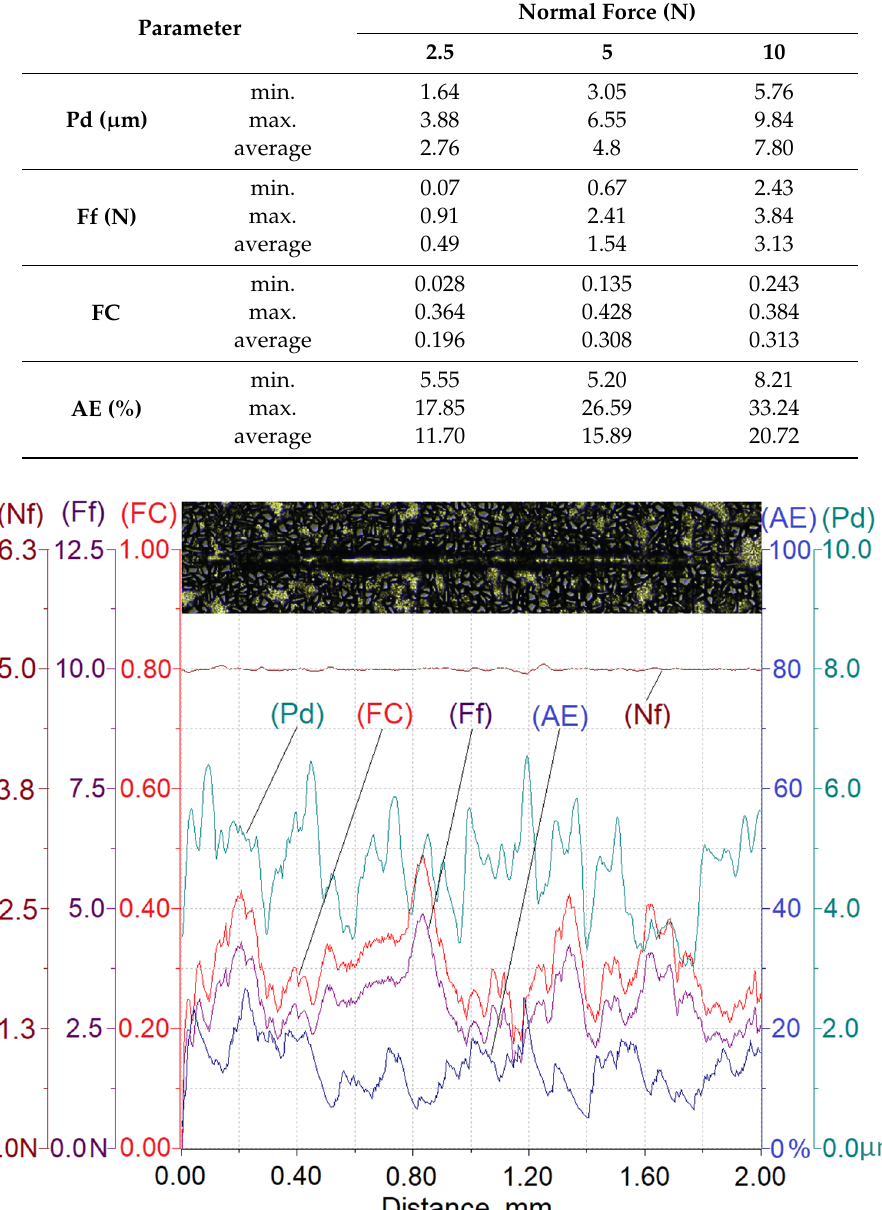
Figure 10. Results of AlSi12/SiC p composite layer scratch testing for the normal load force Nf = 10 N; Nf—normal force, Pd—penetration depth, Ff—frictional force, FC—friction coefficient, AE—acoustic emission.